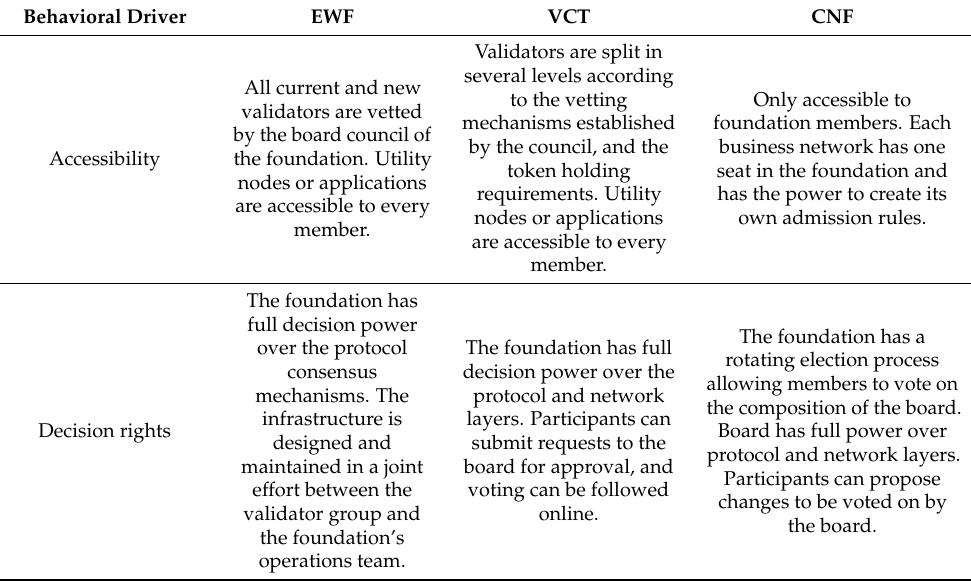
Table 2. Comparison of how the five behavioral drivers are operationalized across the three cases. Behavioral